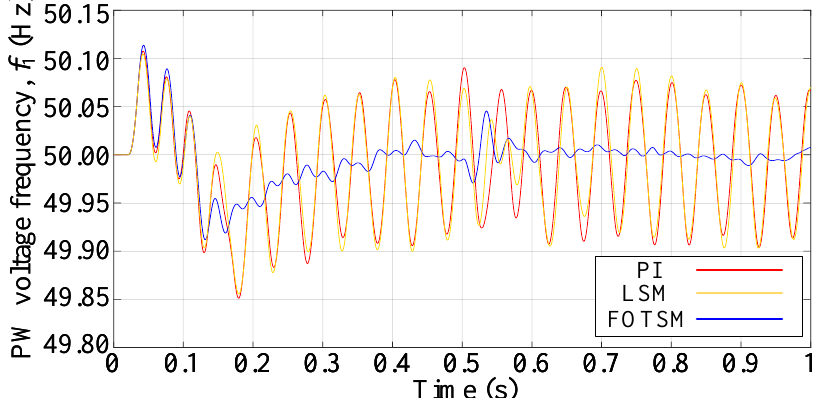
Figure 14. The PW voltage frequency responses under PI, LSM, and FOTSM during the voltage change